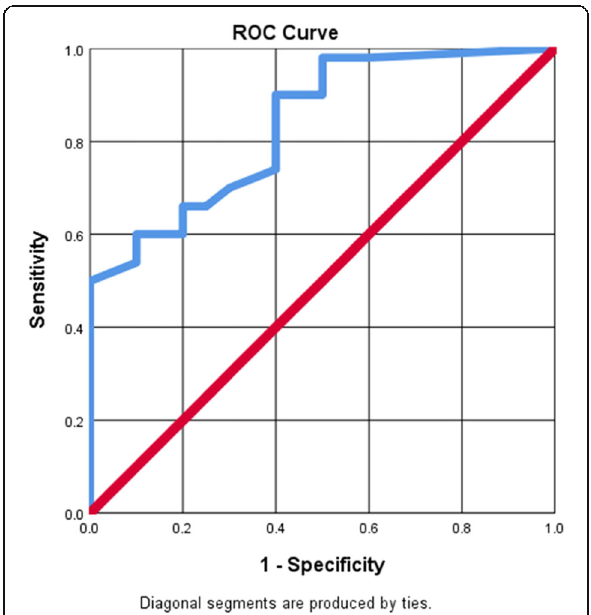
Fig. 4 The results of ROC curve analysis of serum Adrenomedullin concentrations in the studied knee OA patients and normal